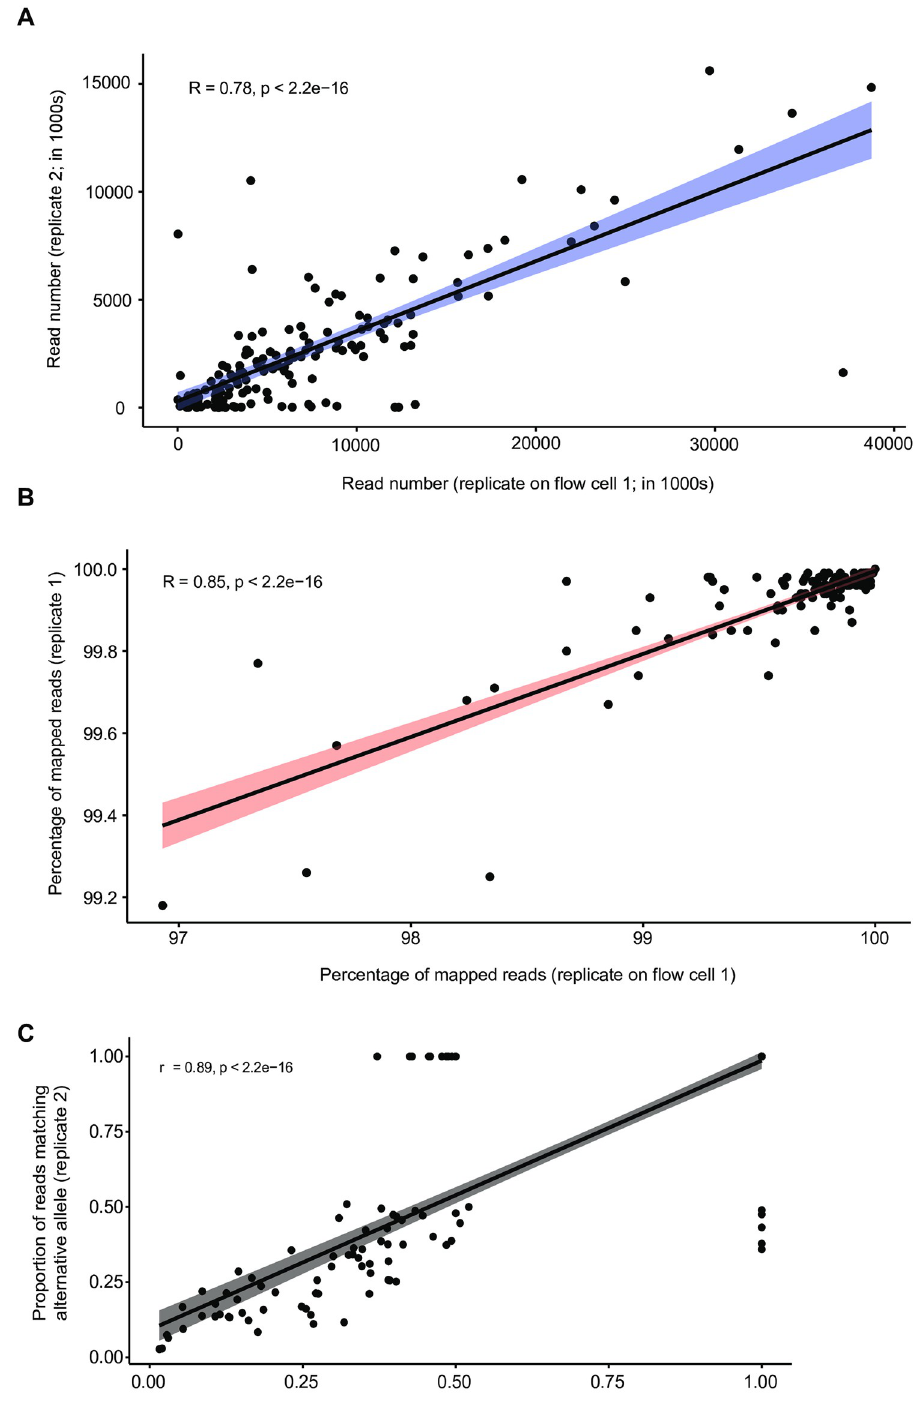
Fig 3. Consistency between replicate runs of the amplicon assay. A) Read numbers per sample and B) percentage of reads mapped to the reference genome. C) Comparison of alternative allele frequencies within samples between the two replicate runs for each